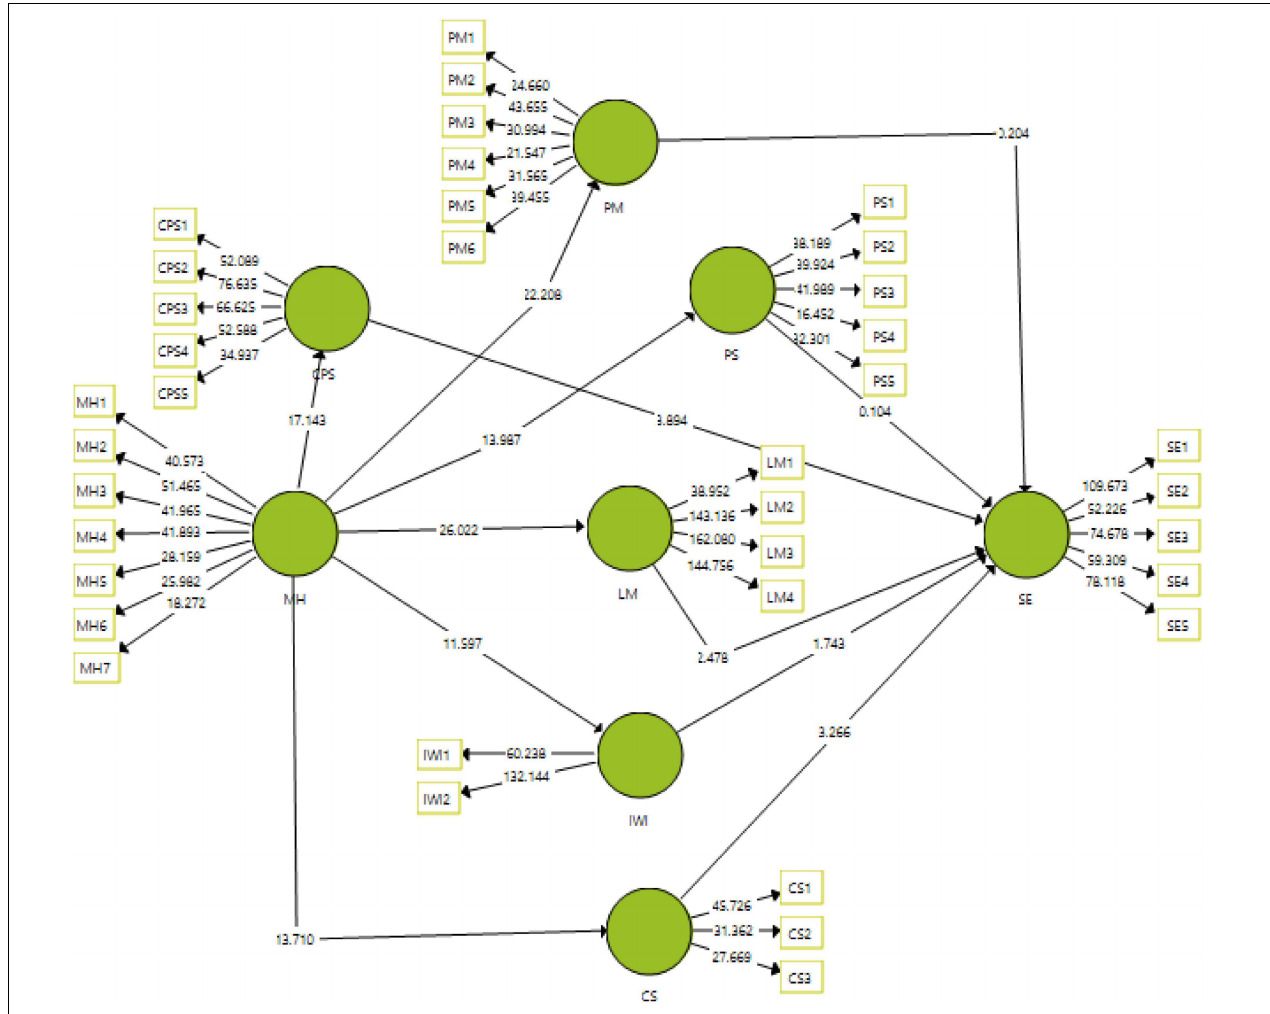
FIGURE 3 | Structural model